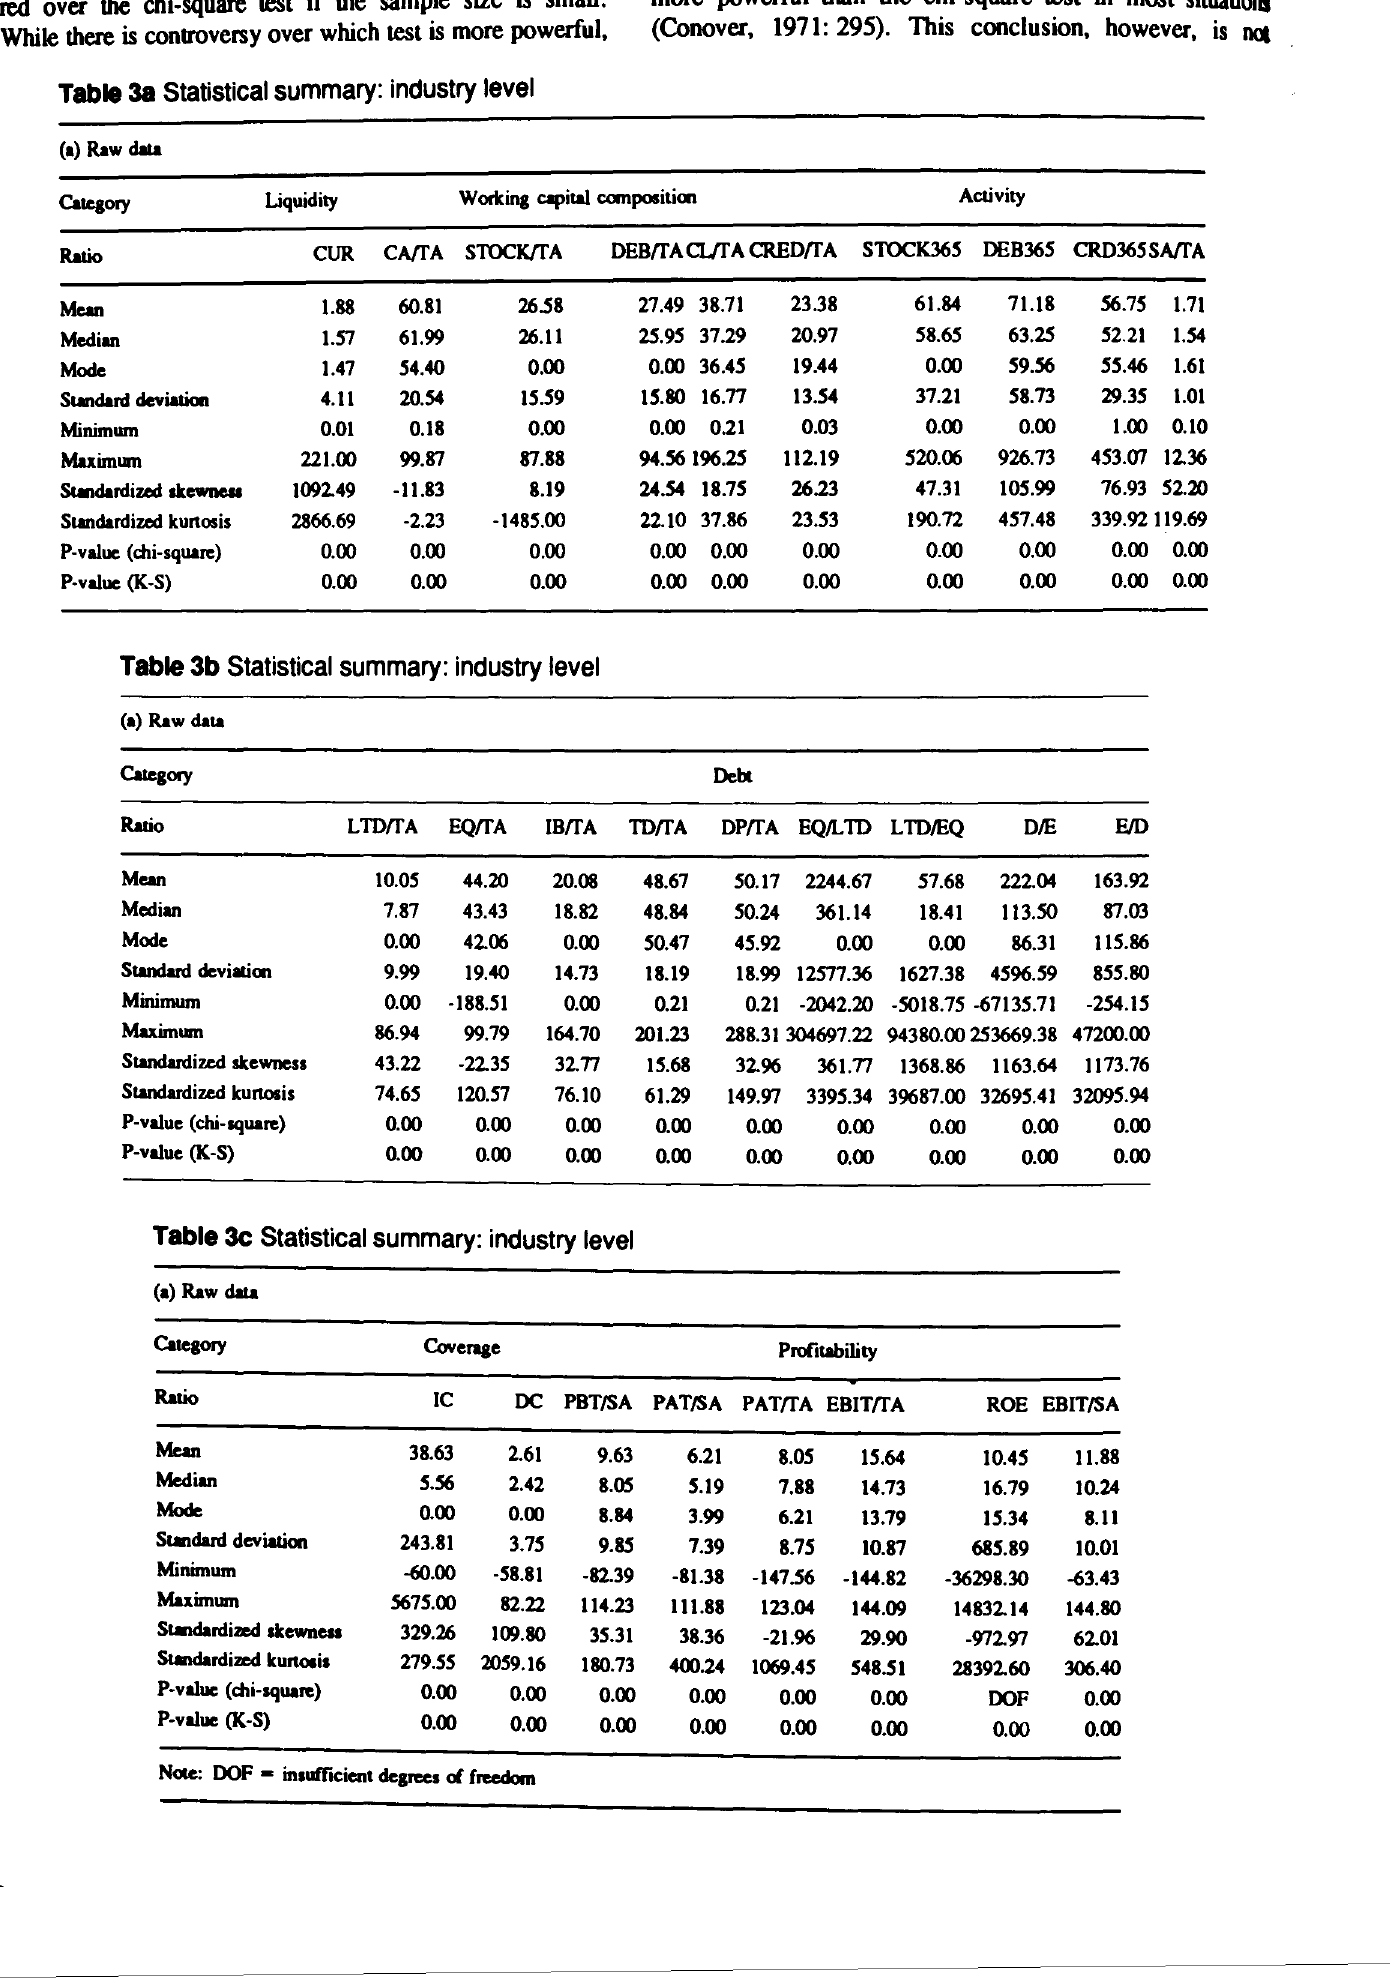
Table 3b Statistical summary: industry level